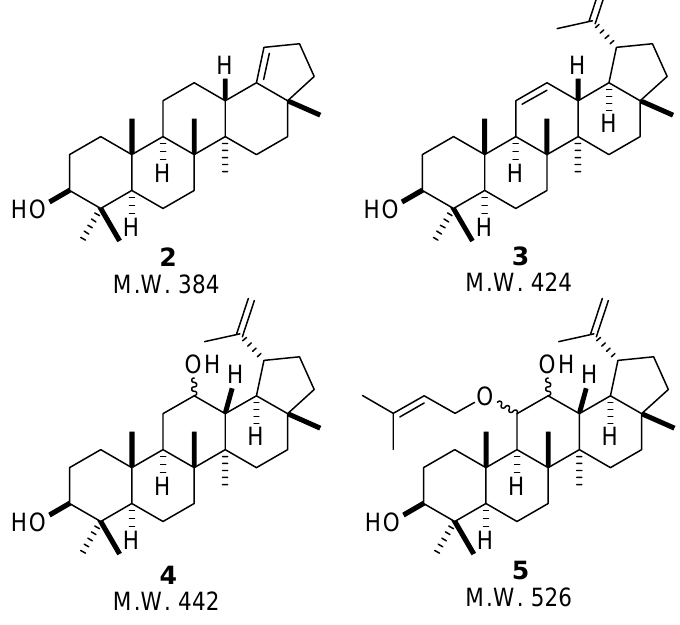
Figure 4. Proposed structures for the biotransformation products of lupeol, produced by A. ochraceus ( 2 and 3 ) and M. rouxii ( 4 and 5 ).